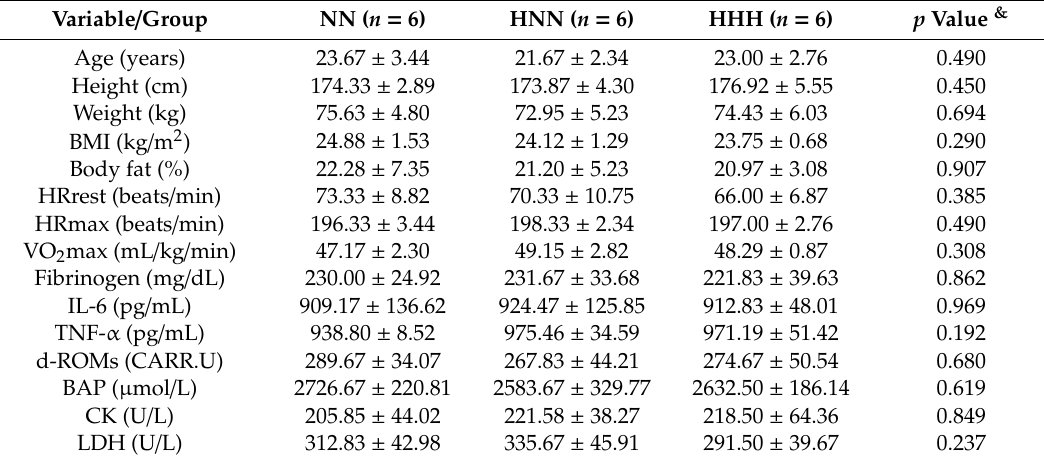
Table 1. Characteristics of the subjects at